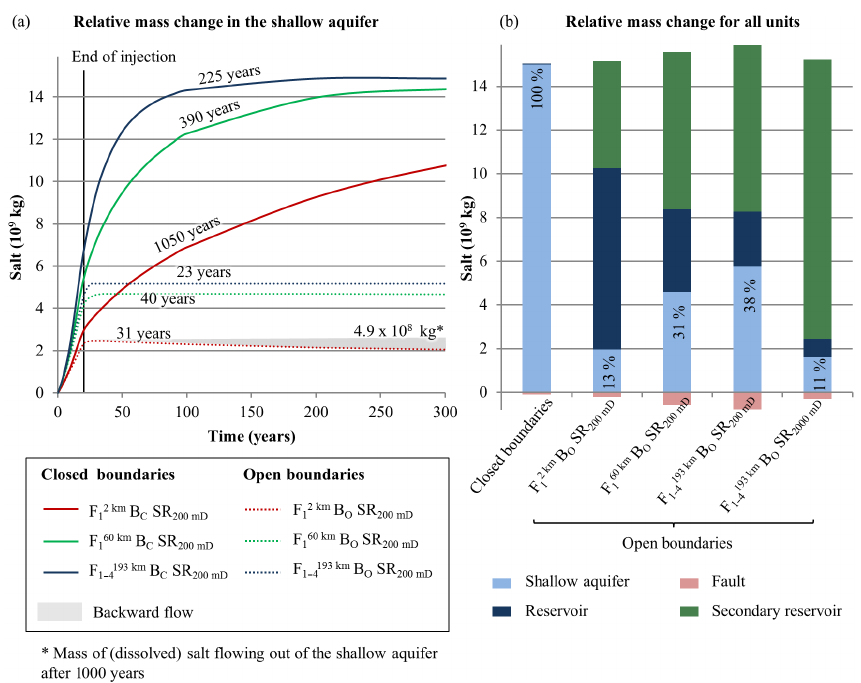
Figure 8. (a) Temporal evolution of the relative salt mass change in the shallow aquifer shows a lower duration of mass flow for open reservoir boundary conditions. Further, a slight backward flow out of the aquifer can be observed if the hydraulically conductive fault length is small. (b) Relative salt mass change for lithological units at 1000 years (considering the backflow) illustrates that salinisation of the shallow aquifer is substantially reduced, if reservoir boundaries are open, and a further overlying secondary reservoir exists. Brine is preferentially displaced into the secondary reservoir, if the permeability of that reservoir exceeds fault permeability ( F 193km